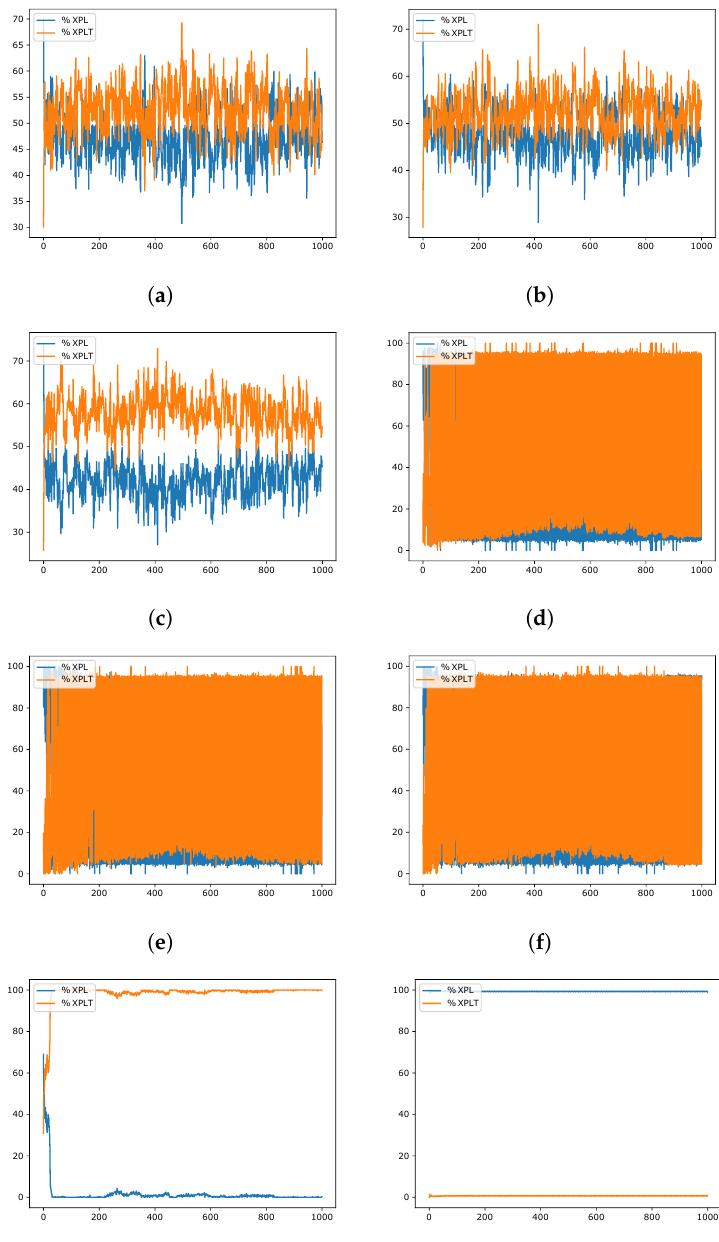
Figure 9. SCA instances exploration–exploitation percentages when resolving the scp51 instance of the SCP. Instance Optimum: 494. ( a ) 80aBQSA—fitness obtained 496; ( b ) 80aQL—fitness